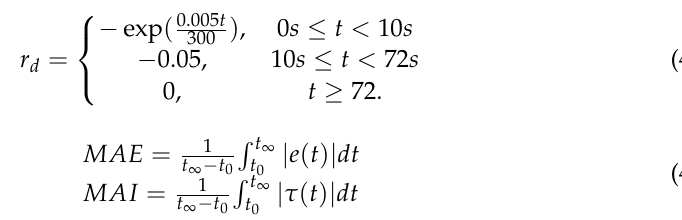
the result in [28] (dot dash line).